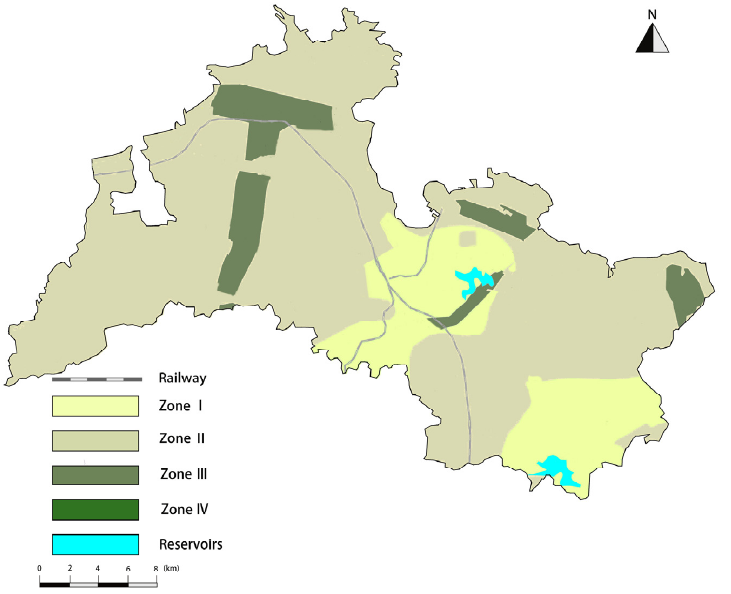
Figure 5. Comprehensive evaluation diagram of underground space resource development suitability (30~100 m).